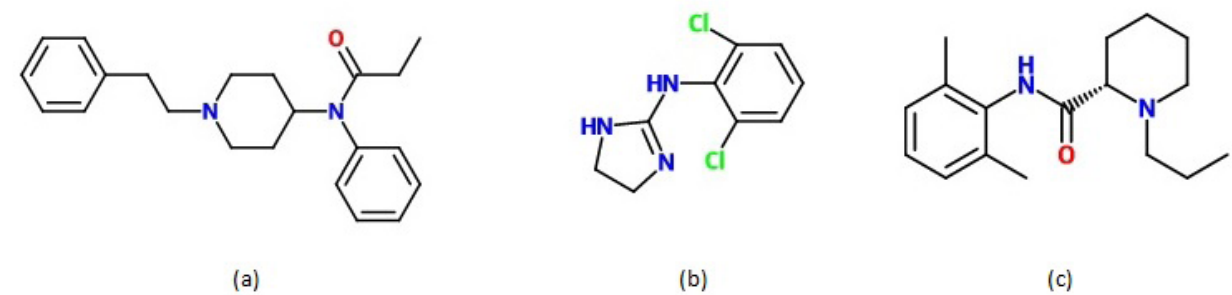
FIGURE 1 - Molecular structures of the following compounds: (a) fentanyl; (b) clonidine; (c)